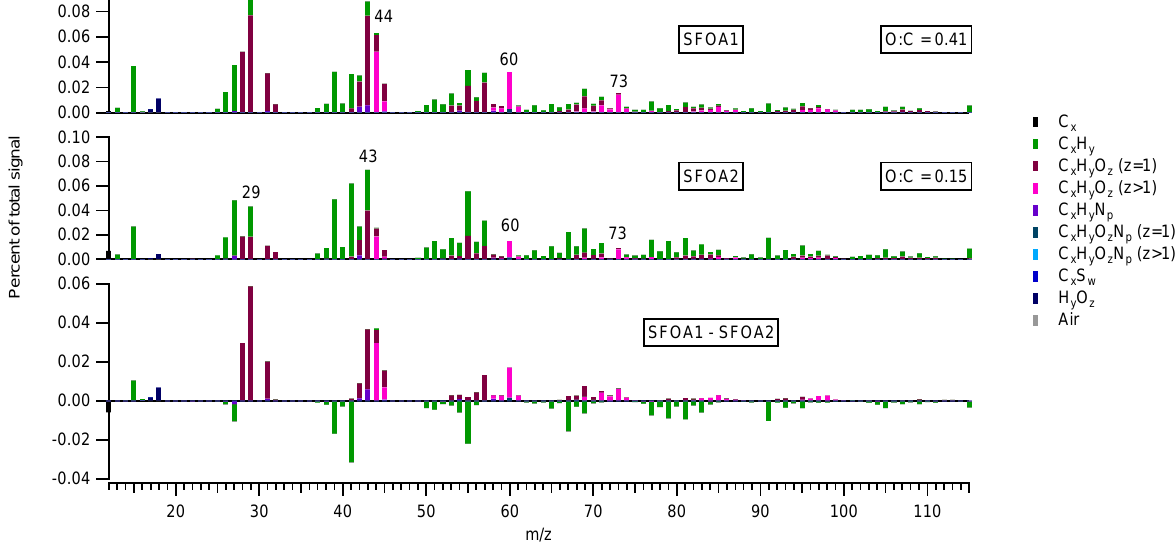
Figure 4. Mass spectra of SFOA1 (top) and SFOA2 (middle) as derived from PMF analysis of the HR-ToF-AMS organic data. Bottom: the difference between the mass spectral profiles of SFOA1 and SFOA2, where there are differences in the structure of the peaks above and below the line, compared to the individual MS of SFOA1 and SFOA2. For example, the peaks above the line are primarily composed of oxidised hydrocarbons at m/z ’s 43, 44, 57 and 60 and the peaks below the line are primarily composed of reduced hydrocarbons. Prominent peaks in the SFOA1 MS such as m/z ’s 41 and 55 are not present above the line in the difference MS and peaks at m/z ’s 43 and 57 in the SFOA2 MS are not present below the line in the difference